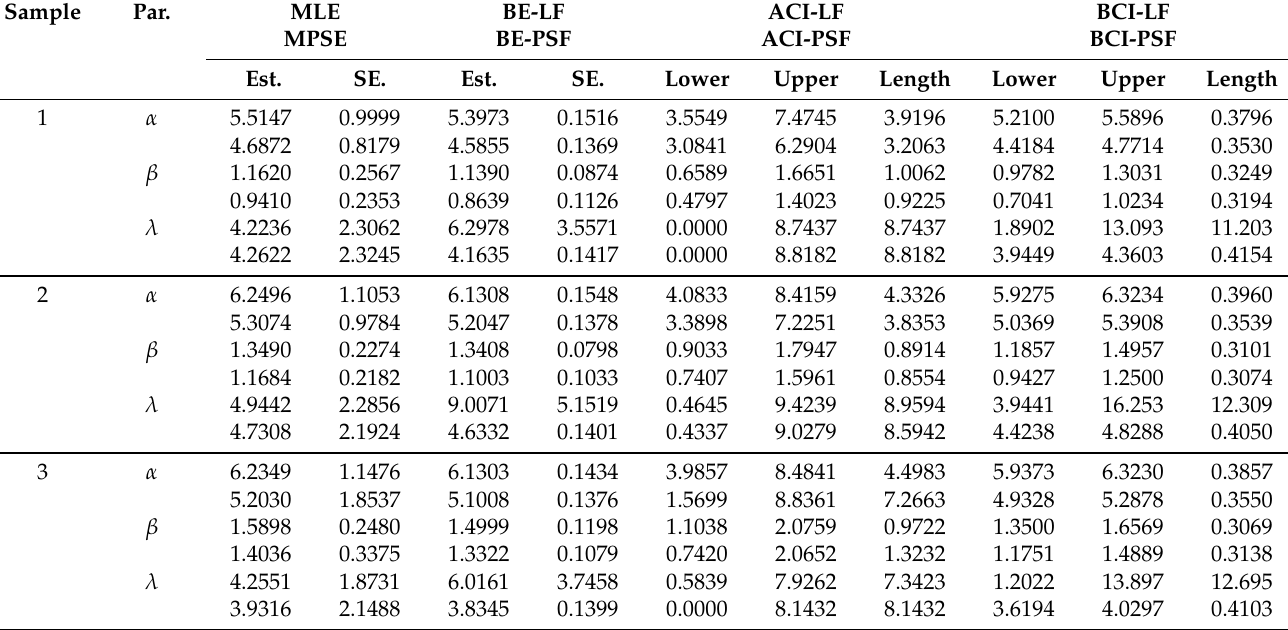
Table 5. Point and interval estimates of α , β , and λ from micro-droplet data.